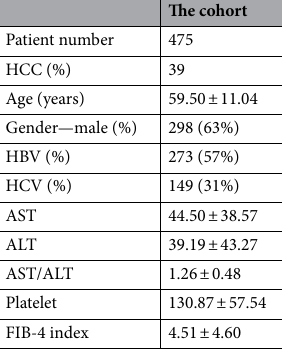
Table 1. Demographic information of the study cohort. HBV, hepatitis B virus; HCV, hepatitis C virus; AST, aspartate transaminase; ALT, alanine transaminase; FIB-4, fibrosis-4.